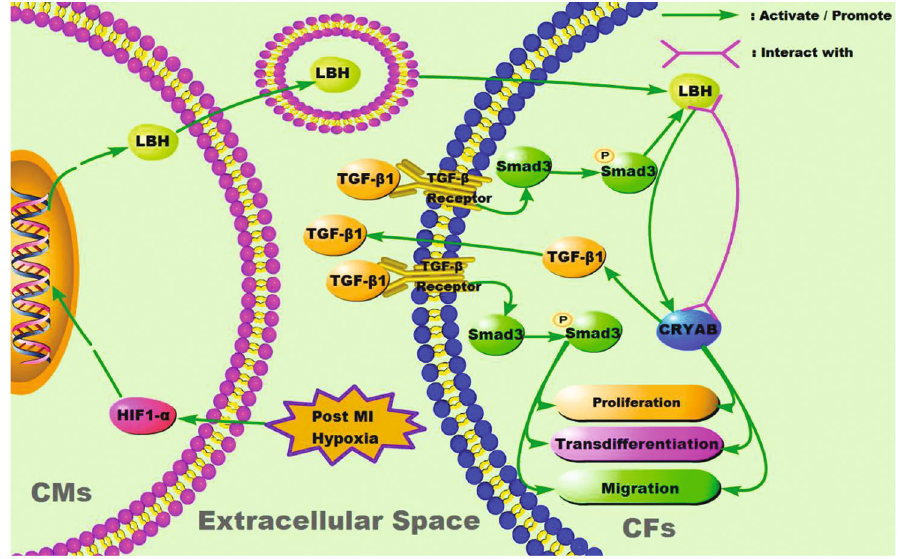
Figure 7: Schematic summary of exosomal LBH related signaling in the post-MI cardiac microenvironment. The LBH-CRYAB signaling responsible for modulating the proliferation, transdi ff erentiation, and migration of CFs could be induced by exosome secretion from LBH-upregulated CMs under